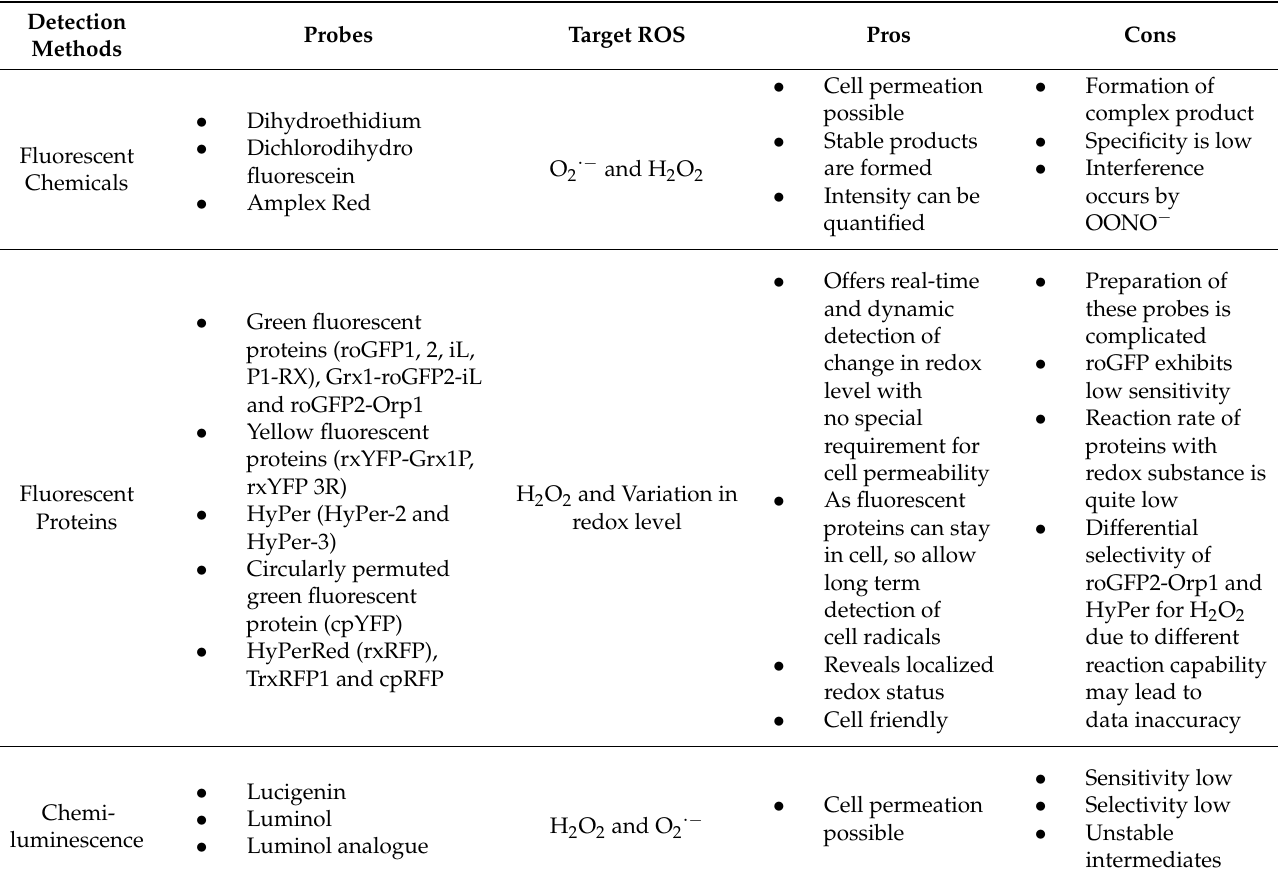
Table 1. The probes, target ROS, pros, and cons of ROS detection